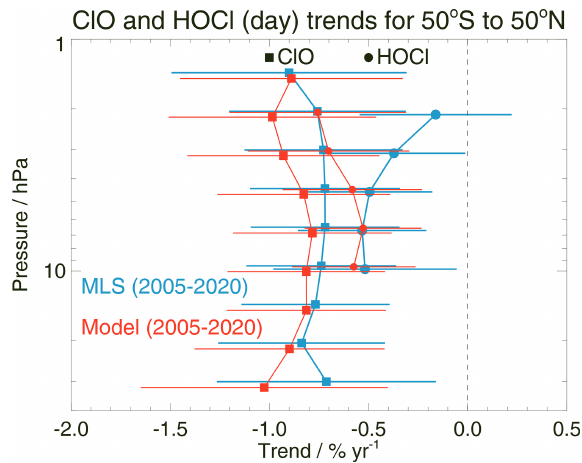
Figure 10. Derived upper stratospheric trends in ClO (filled squares) and HOCl (filled circles) based on regression fits to day- time monthly zonal mean time series for both species, for 50 ◦ S to 50 ◦ N averages from 2005 through 2020; MLS results are in blue and model results in